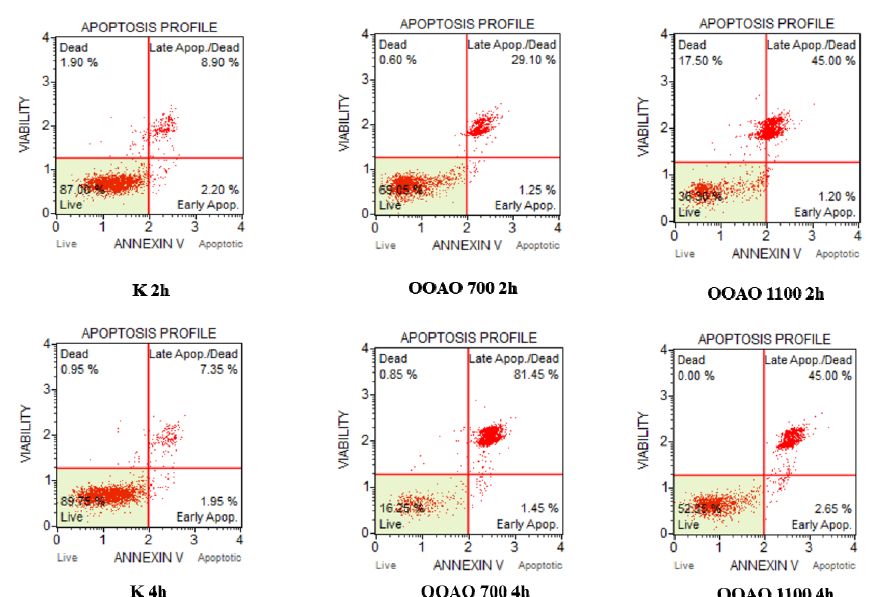
Figure 8. Apoptosis profile (Muse™ Annexin V & Dead Cell Assay) for A549 cells treated with 10% v / v of OOAO 700 and OOAO 1100 and untreated cells (K). Profiles were determined 2 h (upper panels) and 4 h (bottom panels) after treatment. Each plot has 4 quadrant markers, reflecting the different cellular states: the upper left quadrant contains dead cells (necrosis), the upper right has late apoptotic/dead cells (cells that are positive both for Annexin V and for cell death marker 7-AAD, 7-Aminoactinomycin D), the lower left contains live cells, and the lower right early apoptotic cells (cells that are positive only for Annexin V).